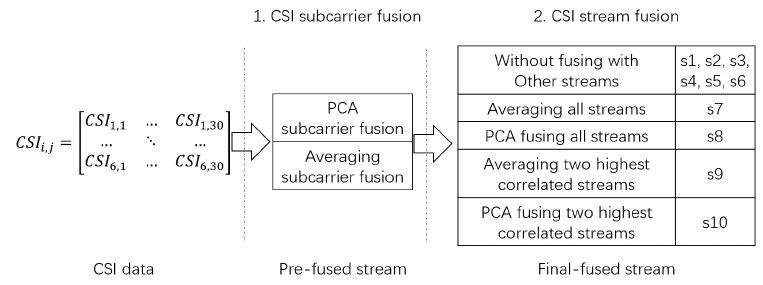
Figure 10. CSI subcarrier and stream data